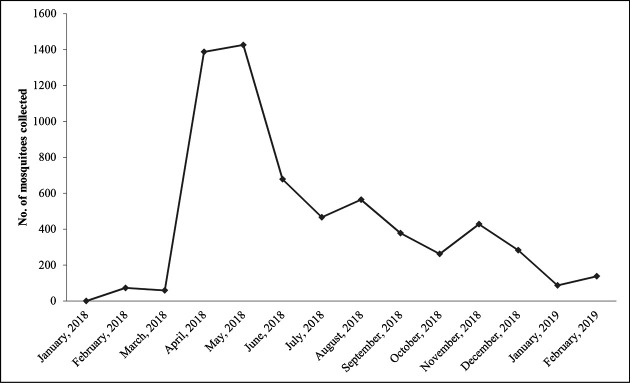
Graphical representation of month-wise Aedes collection.